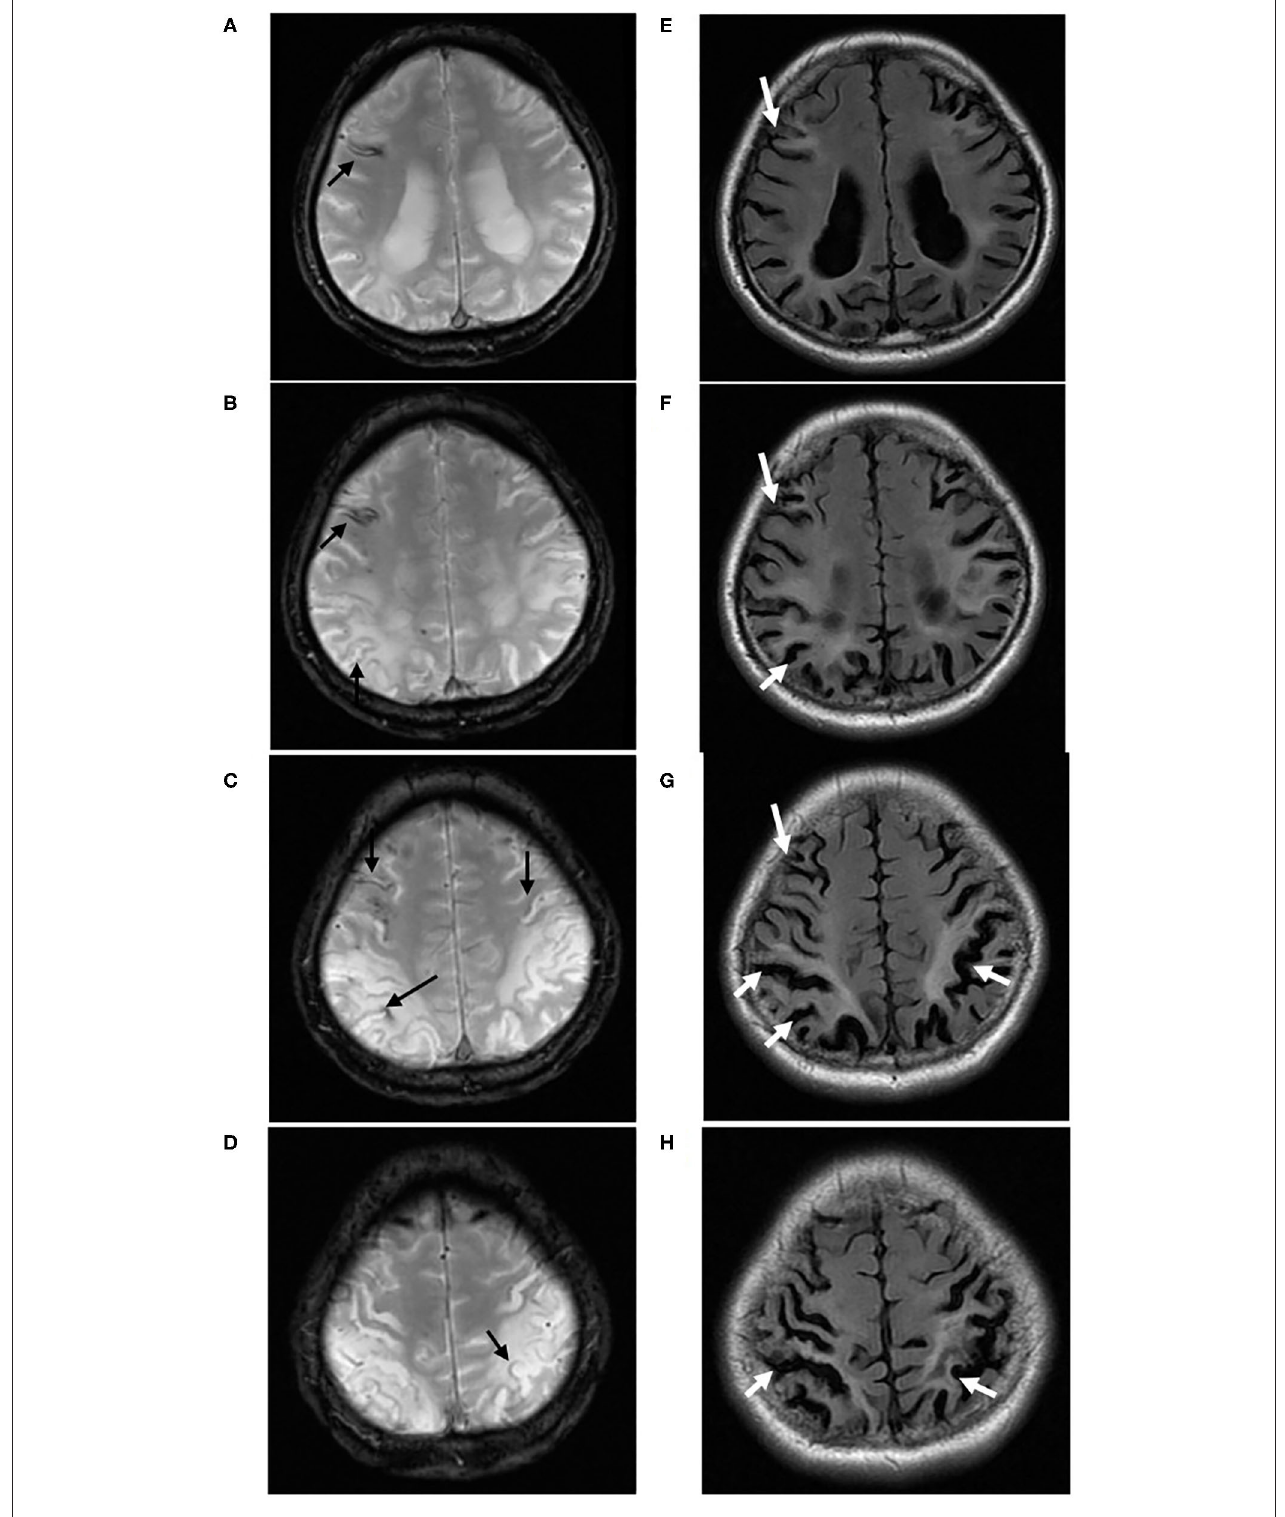
FIGURE 3 | A 40-year-old male (case 5) with Sneddon’s syndrome. Multiple chronic superficial siderosis (black arrow) are observed on T2* sequence, predominantly located in the cortical watersheds (A–D) . On Flair sequences, prominent white matter hyperintensities and cortical atrophy (white arrow) were found surrounding cSS, especially in bilateral parieto-occipital regions (E–H)